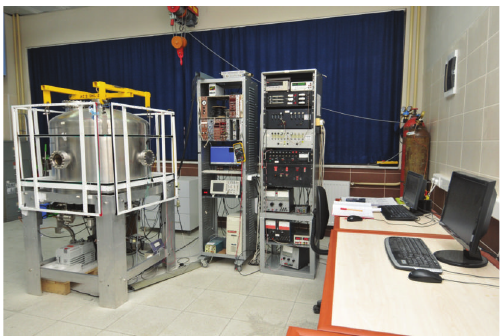
Figure 1: The vacuum chamber with Helmholtz coils, target gas containers, electric and electronic control boxes, and the PC of the experi- mental apparatus at e-COL Laboratory.